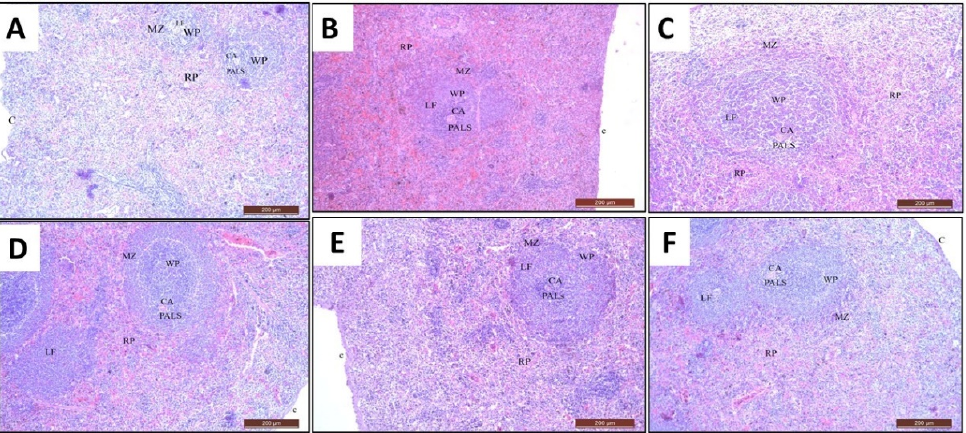
Figure 12. Photomicrographs of section of the spleen stained with H/E ×100 from different groups. ( A ): (Control group) shows capsule (C), white pulp (WP), and red pulp (RP). The white pulp is formed of central artery (CA), periarteriolar lymphatic sheath (PALS), lymphoid follicle (LF), and marginal zone (MZ). ( B ): (OLE group) is similar to control group. ( C ): (Cis group) shows thick capsule and thick trabeculae. There is decreased white pulp density and congested red pulp. ( D – F ) Cis + OLE, Cis + CM-MSCs, and Cis + MSC groups respectively show restoration of normal histological structure of the spleen.